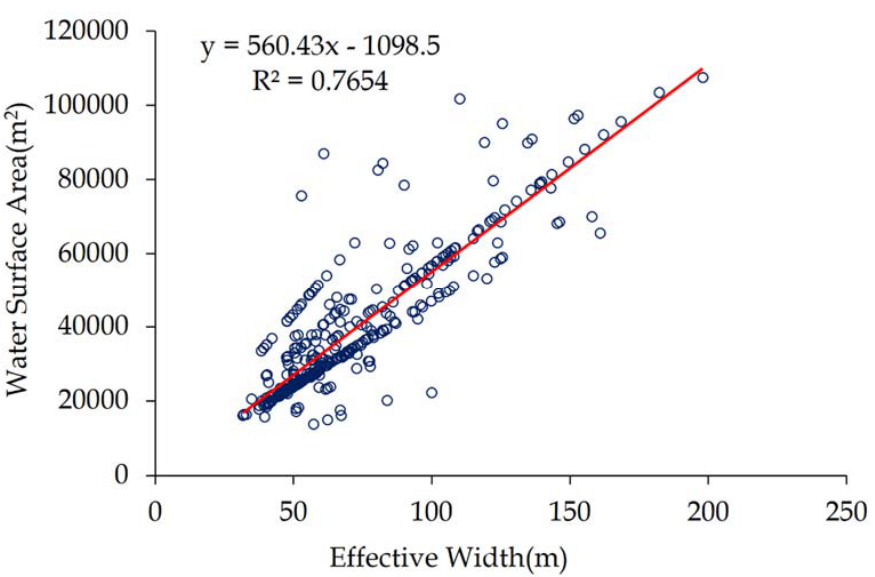
Figure 5. Scatterplots of WSA versus average effective width derived from Landsat satellite images at Lhasa gauging station over the study period of 1988–2018.